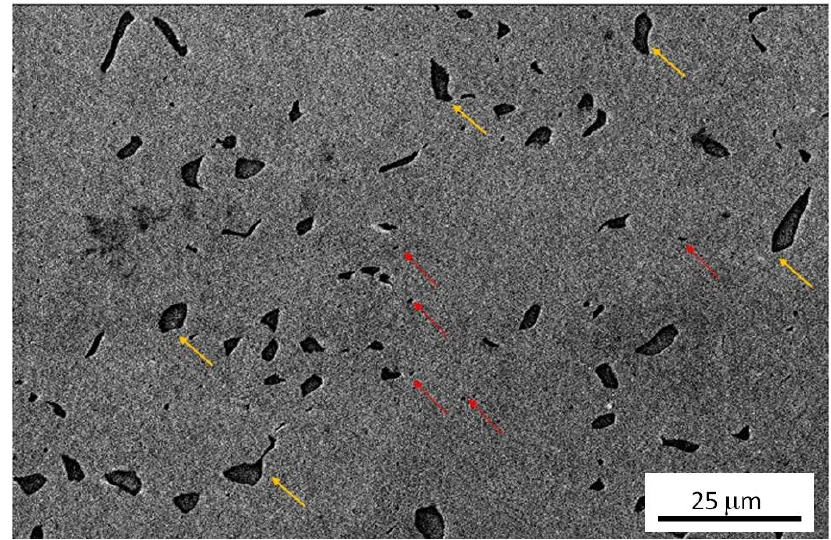
Figure 2. SEM image evidences the presence of two types of particles: the larger particles (~10–15 μm) are indicated by yellow arrows, the smaller ones (~1 μm) by red arrows.